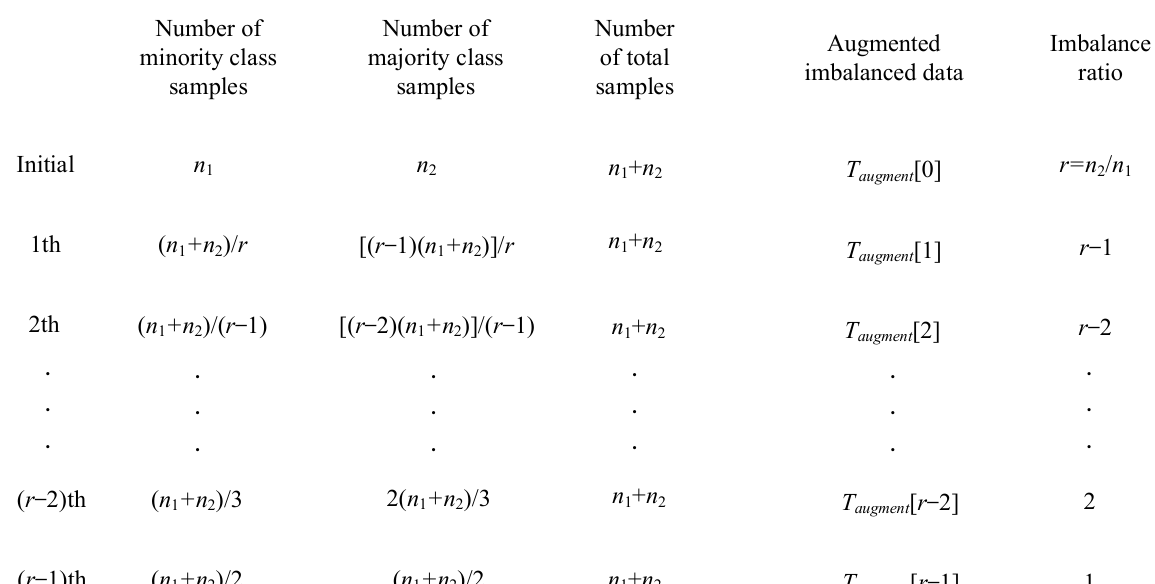
Figure 4. Relationship between the augmentation process and IR change in Algorithm 3.